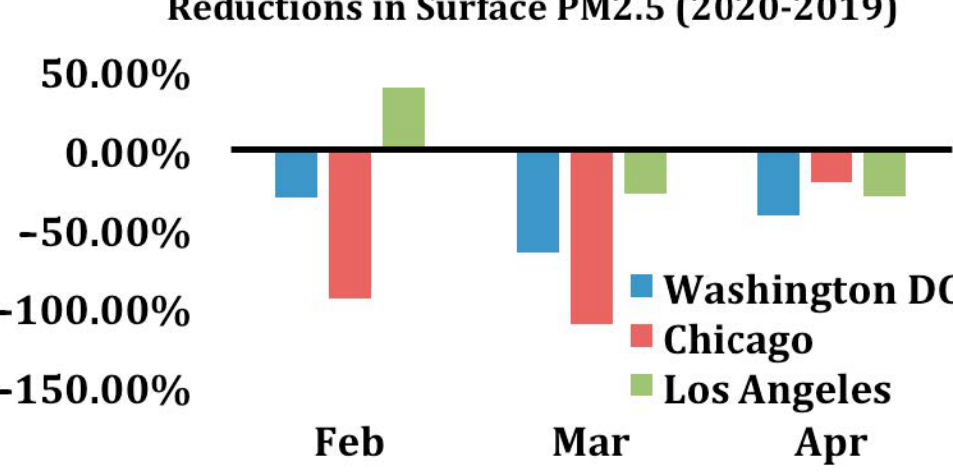
Figure 17. Distribution of surface PM 2.5 in Washington, DC, Chicago, and LA during